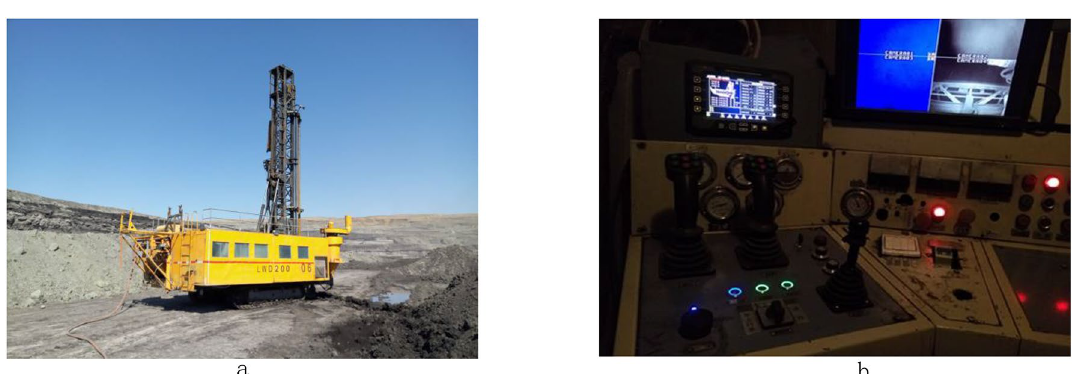
Figure 4. Lithology identification system of intelligent drilling rig: ( a ) LWD-200B hydraulic drilling rig; ( b ) lithology identification